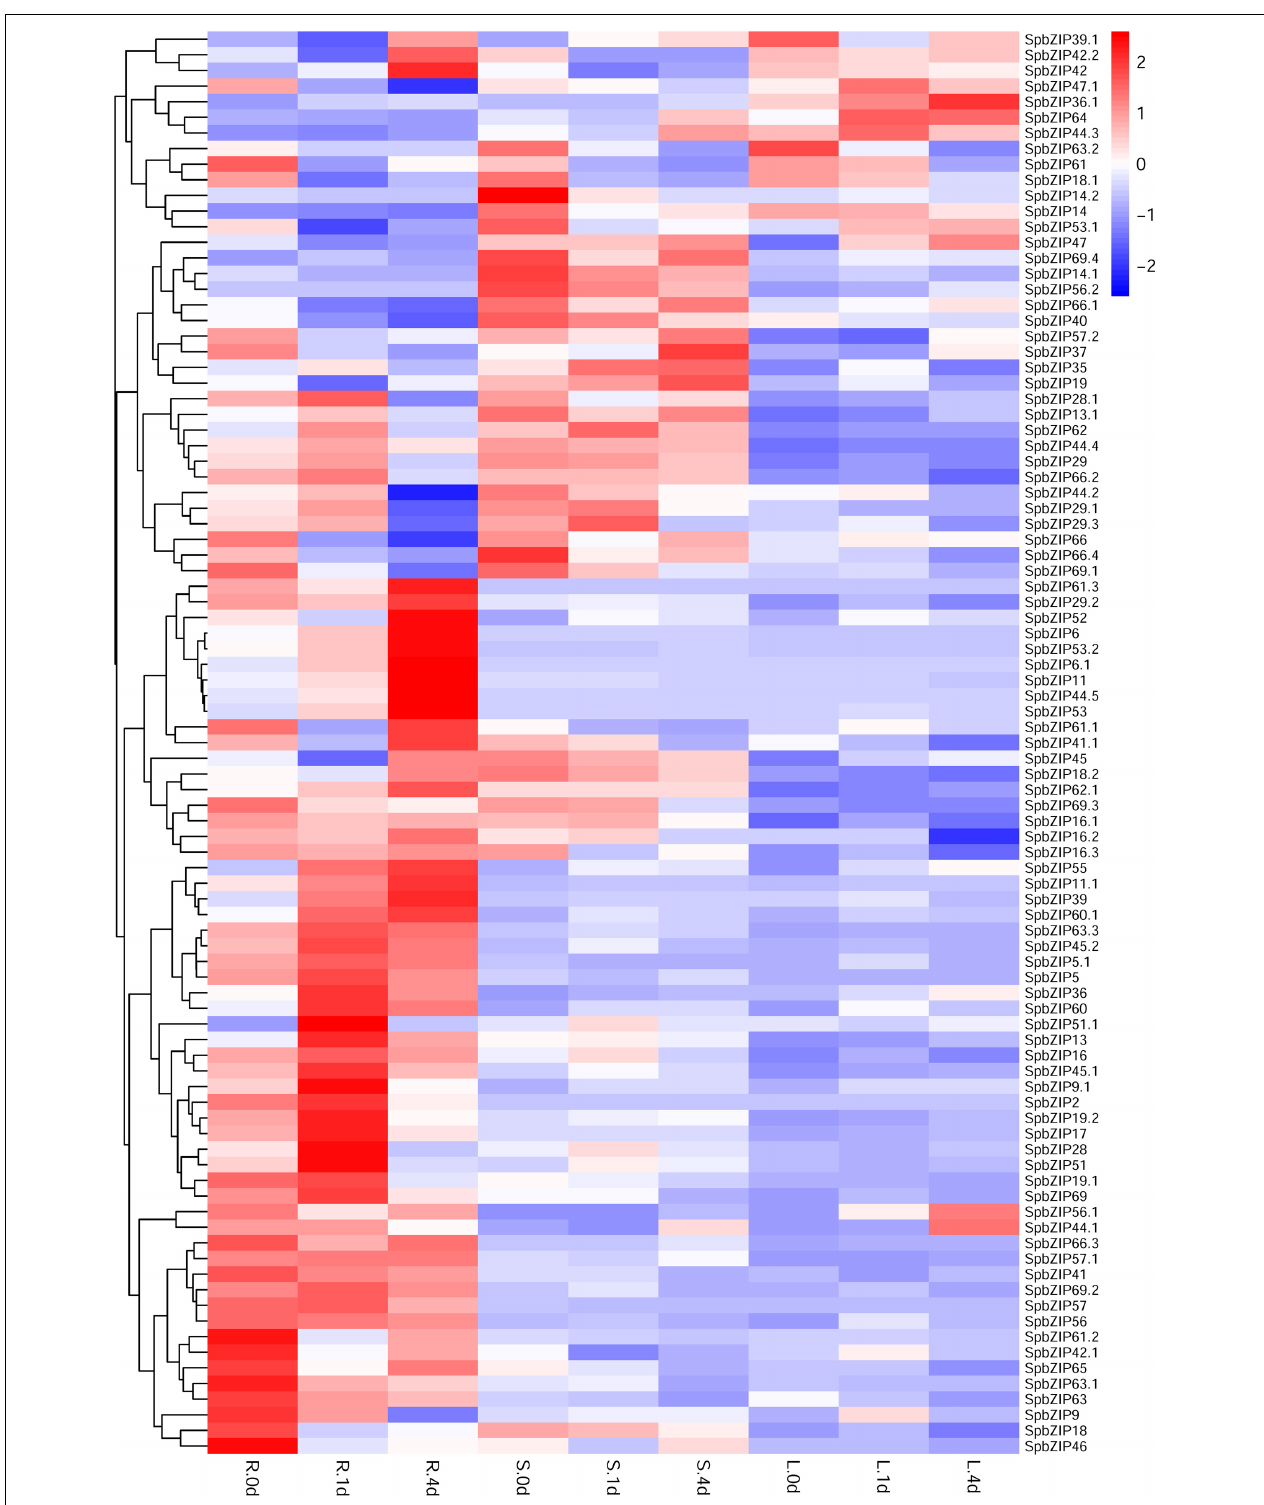
FIGURE 6 | Expression profiles of SpbZIP genes in plant tissues under Cd stress conditions. Gene expression data at 0, 1, and 4 days after the 400 µ M CdCl 2 treatment were retrieved from an RNA-seq database and visualized using R (version 4.0.2). Expression levels are indicated by a gradient from low (blue) to high (red). L, S, and R represent leaves, stems, and roots,